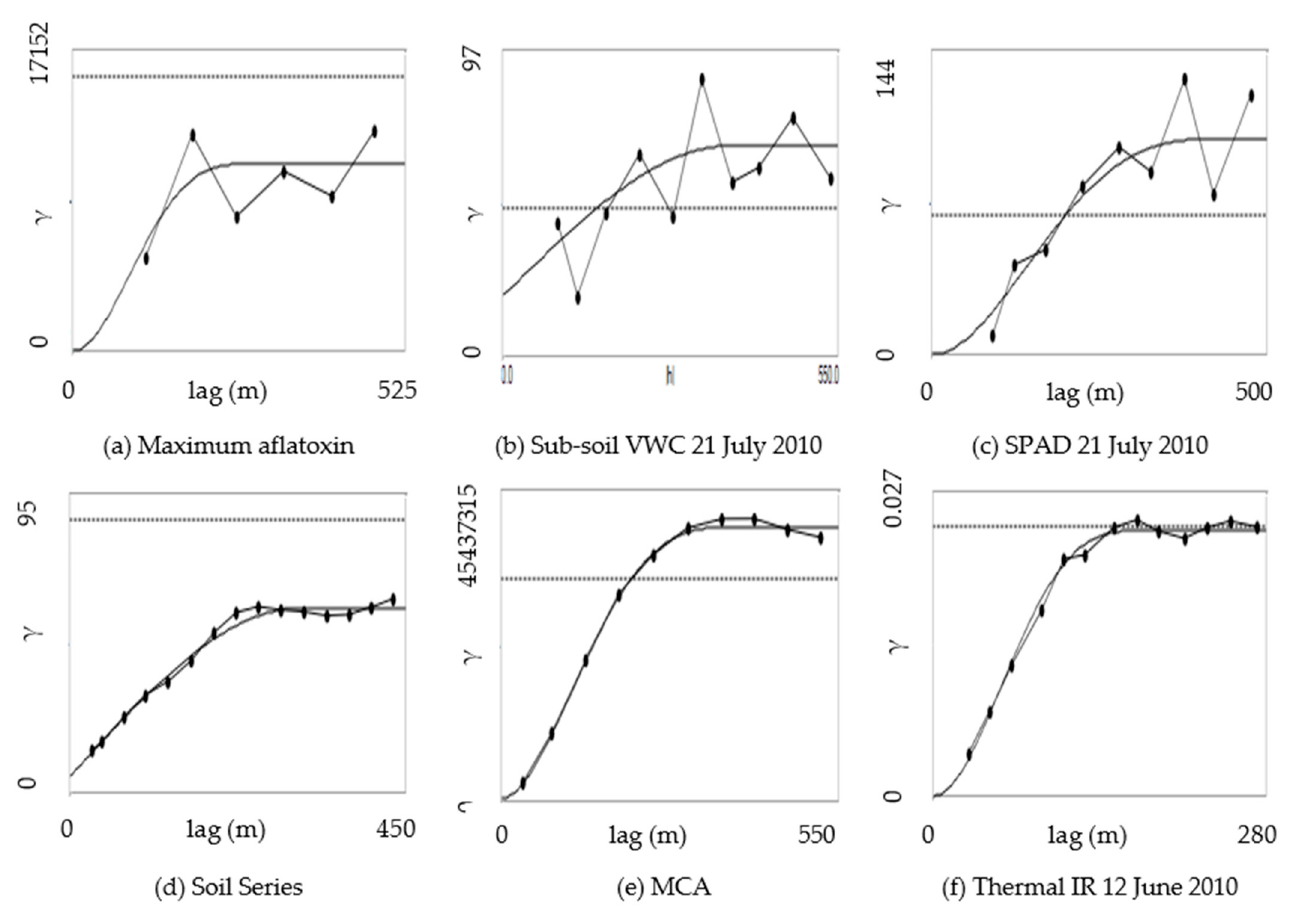
Figure 5. Sample variograms for ( a ) maximum aflatoxin, ( b ) sub ‐ soil VWC 21 July 2010, ( c ) SPAD 21 July 2010, ( d ) soil series, ( e ) MCA and ( f ) thermal IR 12 June 2010.